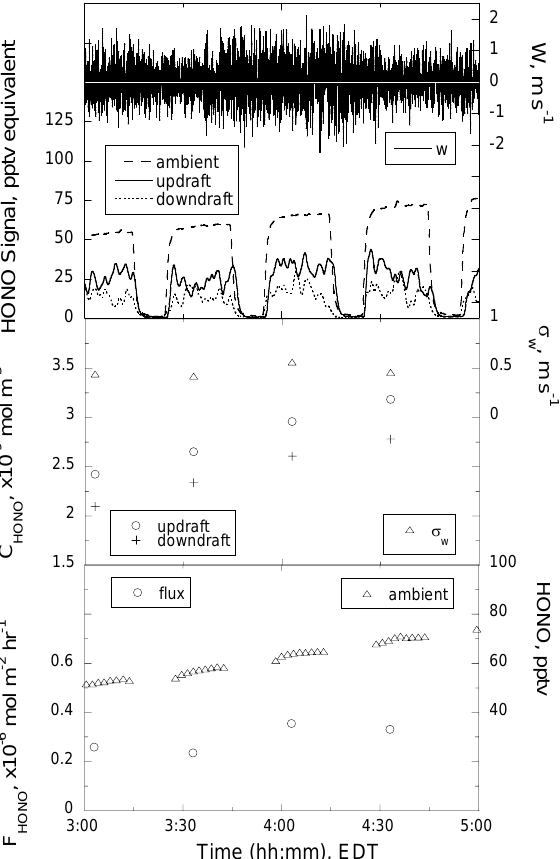
Fig. 4. Examples of raw and processed data collected during a 2- h period on 25 July 2008. Upper panel: raw data of vertical wind speed (10Hz) and HONO signals (0.3Hz) from ambient, updraft and downdraft HONO systems. Middle panel: 20-min averages of HONO concentrations in updraft and downdraft air masses, and the standard deviation of vertical wind speed. Lower panel: derived am- bient HONO concentrations and flux